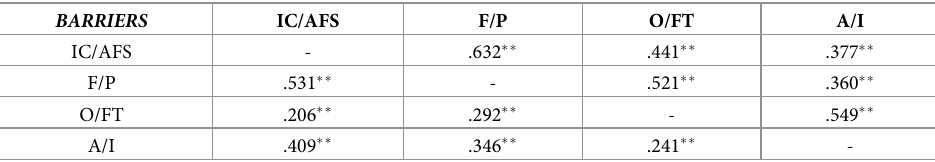
Note: The correlations above the diagonal belong to the sample of preadolescents (N = 239) and those below the diagonal belong to the sample of adolescents (N = 842). Significant correlation to levels